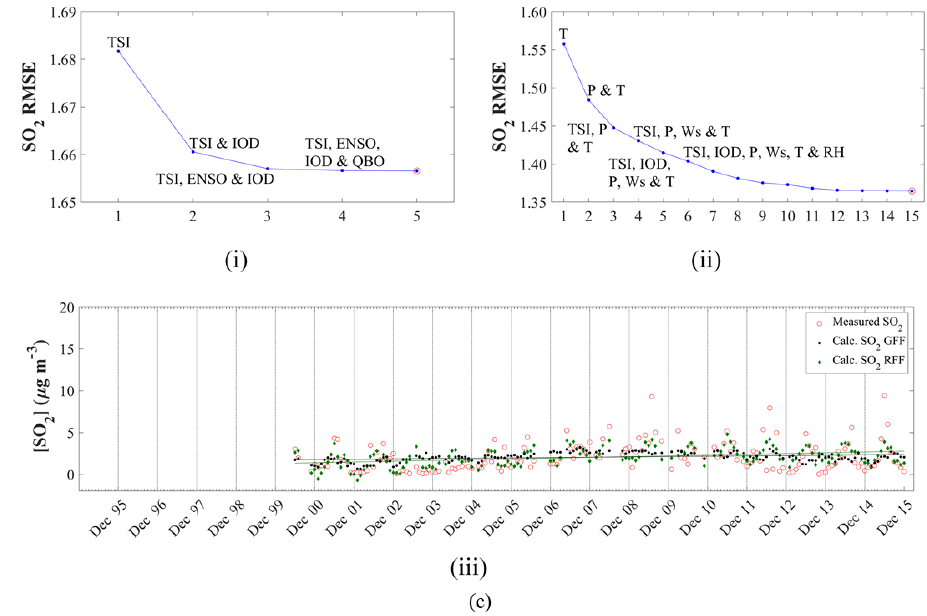
Figure 9. (i, ii) RMSE differences between modelled and measured SO 2 concentrations as a function of the number of independent variables included in the model, as well as a comparison between modelled and measured SO 2 levels (iii) for global force factors only (GFF) and for global, regional and local factors (RFF) determined for AF (a) , LT (b) and SK (c) . Table 1. Regression coefficients ( b ) and relative-importance weight percentage (RIW%) of each independent variable included in the MLR model to calculate SO 2 concentrations at AF, LT and